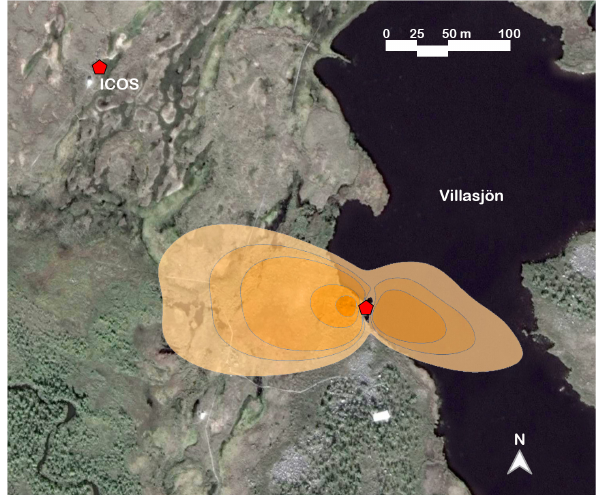
Figure 1. Map of the Stordalen mire study area, showing our EC tower by the shore of Villasjön and the nearby ICOS station lo- cation that provided the vegetation surface temperature data. The shaded area represents the combined fen and lake footprint for the July EC measurements, at flux contribution intervals of 85%, 80%, 75%, 50%, and 25%. The base map image is from © Google Earth (image provided by